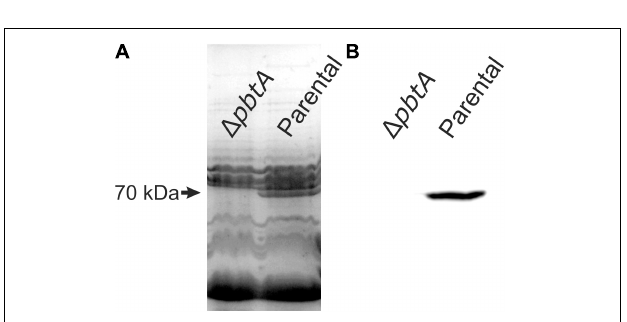
FIGURE 3 | Outer membrane protein (OMP) band patterns (A) and detection of TonB-dependent piscibactin transporter FrpA by Western blot (B) in the V. anguillarum parental strain RV22 (cid:49) vabF and in the (cid:49) pbtA ( (cid:49) araC1 ) mutant cultured under low-iron